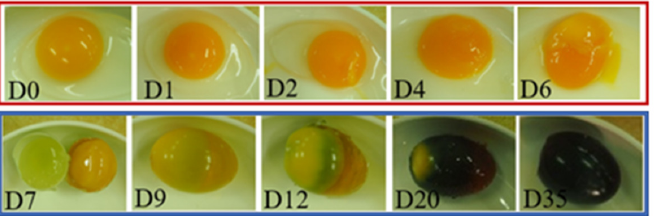
Figure 4. Evolution of albumen and yolk during pickling. They gradually solidified in the first six days and then began to discolor after a week. The “D” in the figure means “day”. The conditions for producing pickled eggs are stricter than those for producing salted eggs. It is necessary to maintain complete eggshells throughout the production process, and the pickling conditions must be controlled to prevent incomplete gelation or over- marination, which reliquefies egg whites. Incorrectly marinated pickled eggs have a strong pungent smell and are not suitable for human